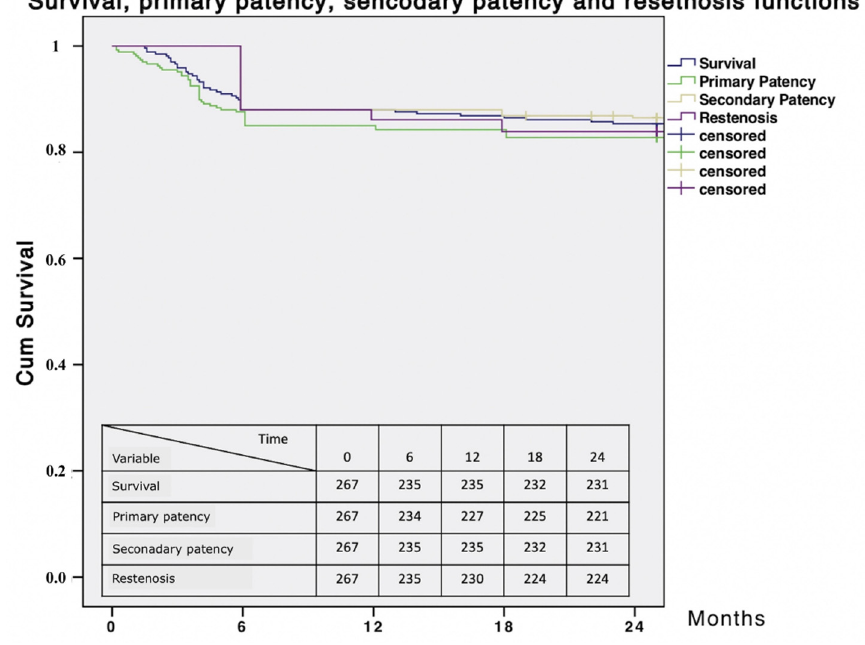
Figure 7. Survival, primary patency, secondary patency and restenosis curves.